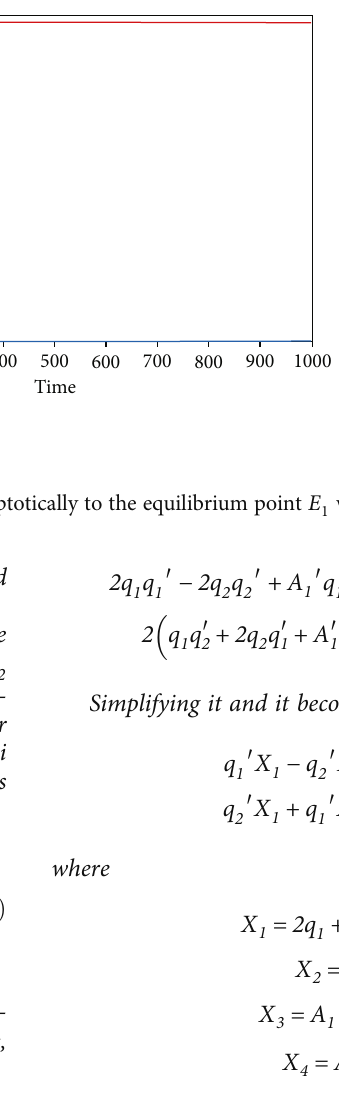
Figure 4: (a) Time series solution and (b) parametric plot of system (4) about the equilibrium point E except c 2 = 0 : 1, c 1 = 0 : 12, α = 0 : 25, and β = 0 : 2